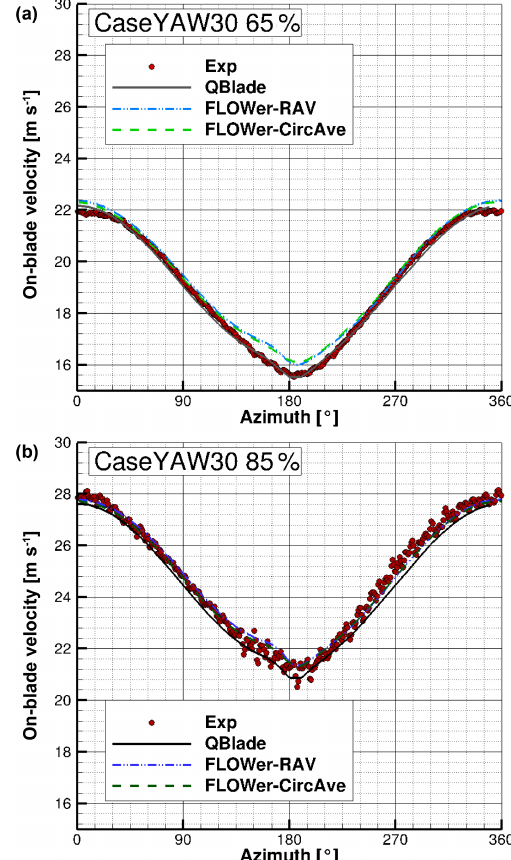
Figure 14. On-blade velocity distribution over the azimuth for CaseYAW30 for the experiment, QBlade and FLOWer (RAV and CircAve) at 65% R (a) and 85% R (b) .